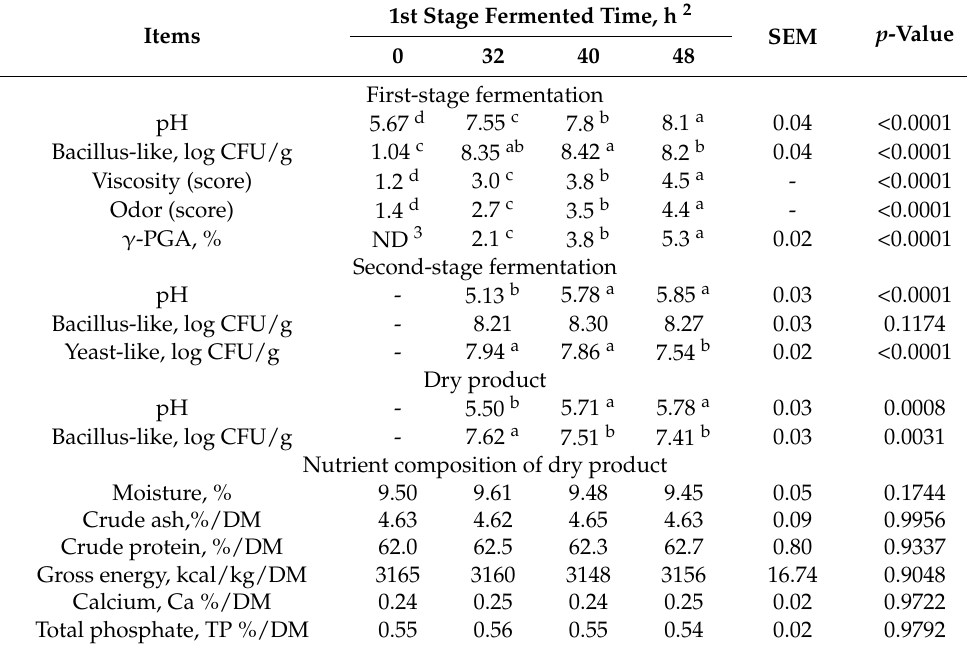
Table 3. Physiochemical characterizations of TSFP 1